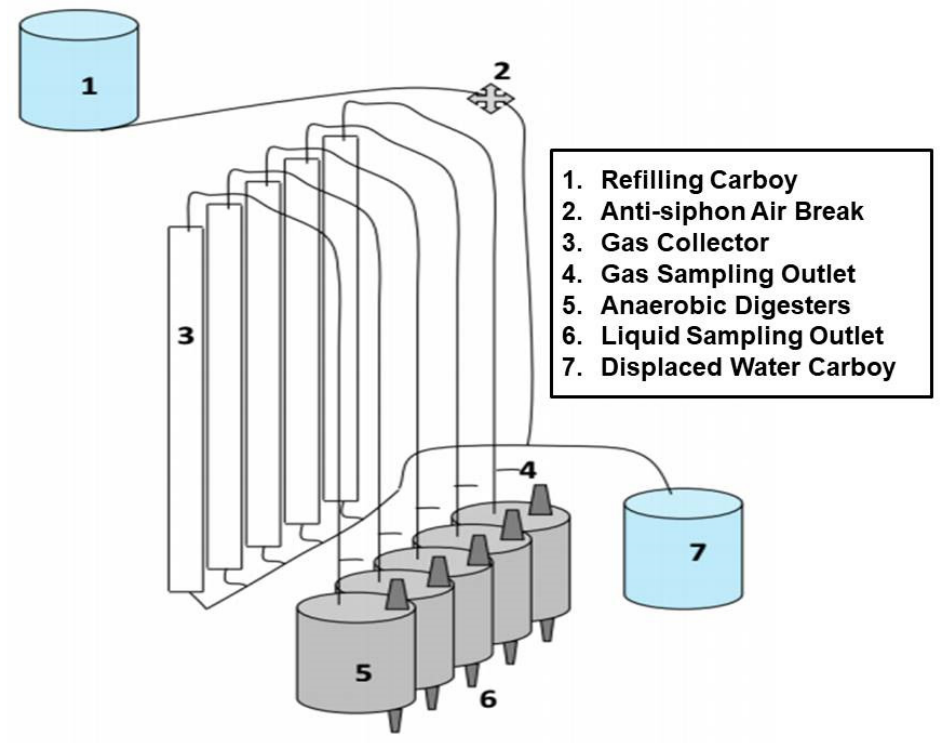
Figure 1. Layout of the experimental setup.